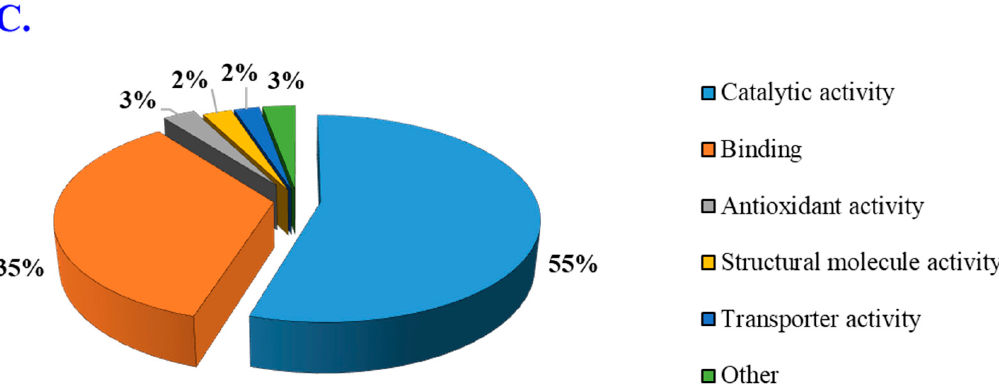
Figure 4. GO classification of differentially abundant proteins divided into three categories. ( A ) Bi- ological processes. ( B ) Cellular components. ( C ) Molecular functions. Each category contains meta-